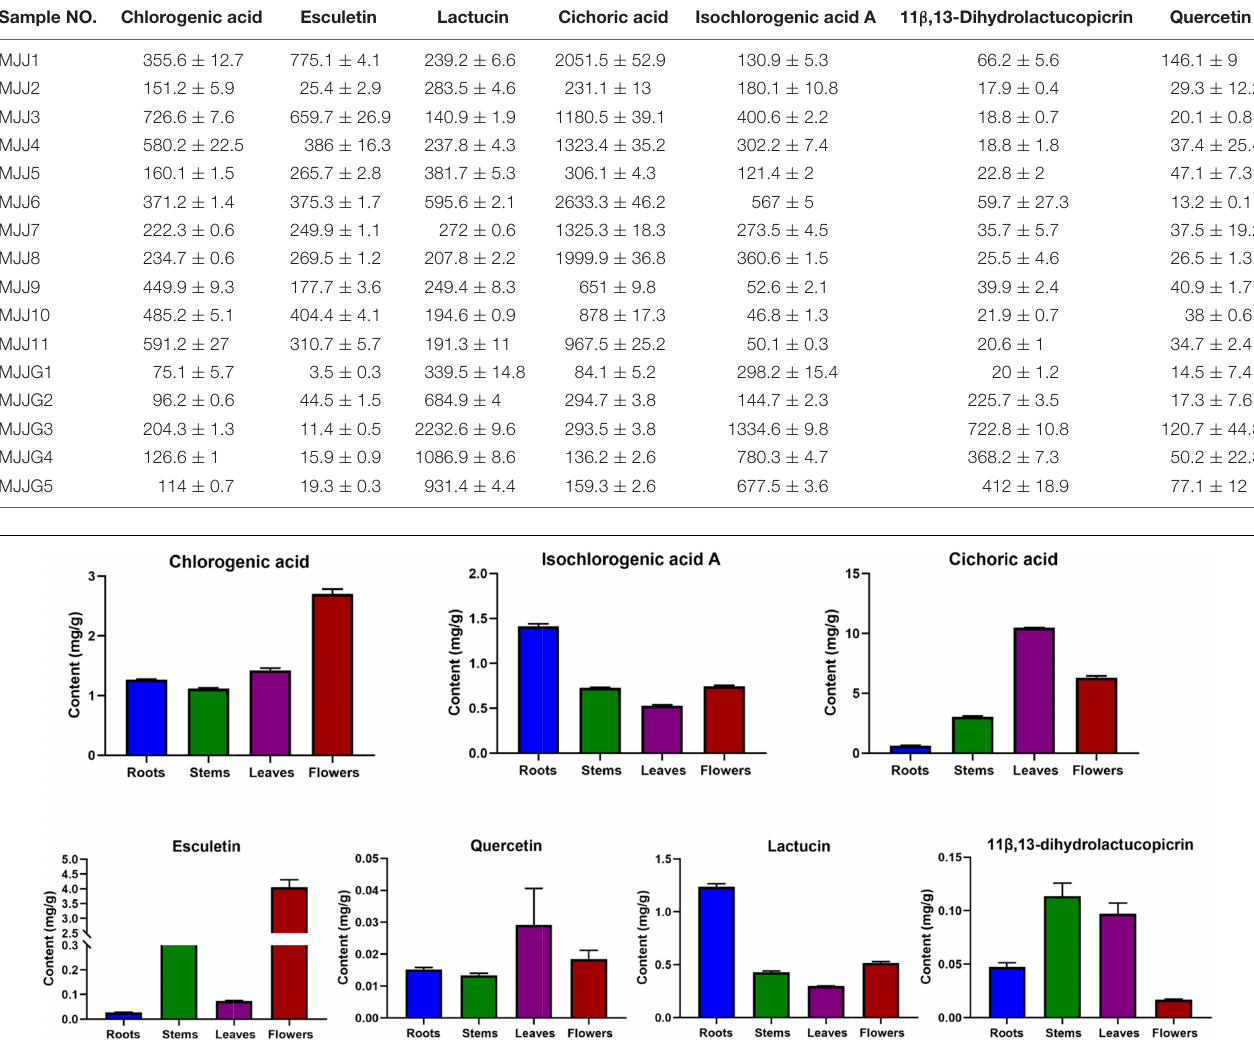
TABLE 4 | Content characteristics of seven compounds in Cichorium glandulosum Boiss.et Huet (mean ± SD, µ g/g). Sample NO. Chlorogenic acid